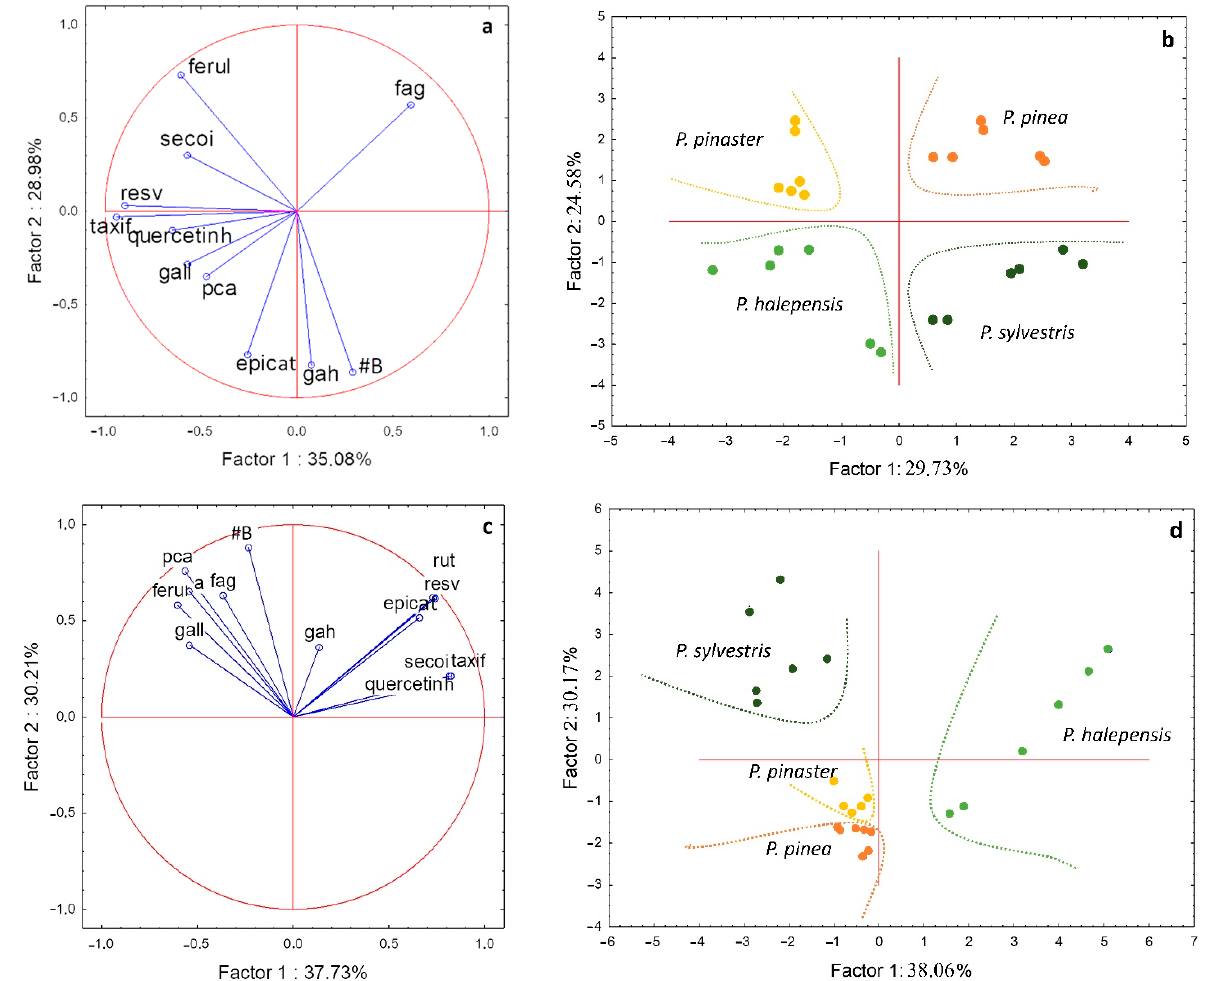
Figure 4. Principal component analysis (PCA, ANOVA test) of the coordinates of the treatment (wa- ter-inoculated ( a , b ) and pinewood nematode-inoculated trees ( c , d )) and the pine species ( P. halepen- sis , P. pinea , P. sylvestris , and P. pinaster ) at 72 h, on a graph defined by two